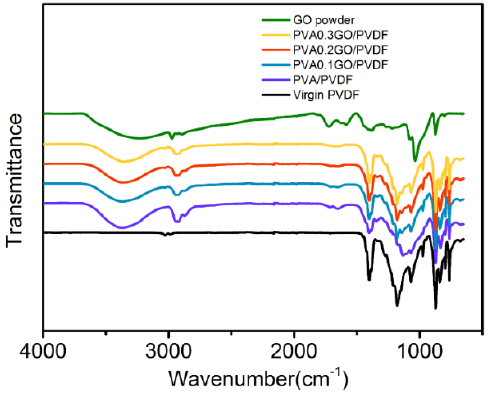
Figure 8. FT ‐ IR curves of PVA ‐ GO/PVDF membranes with GO loading of 0.1, 0.2 and 0.3 wt. %. Figure 8. FT-IR curves of PVA-GO/PVDF membranes with GO loading of 0.1, 0.2 and 0.3 wt.